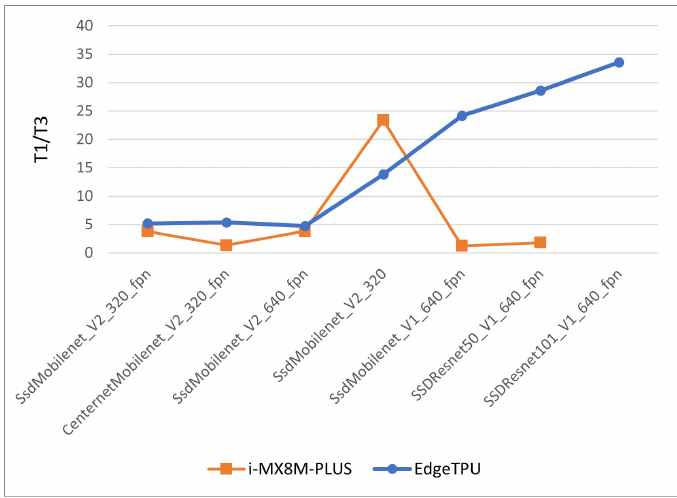
Figure 20. Inference time improvement factor calculated using quantization levels 1 and